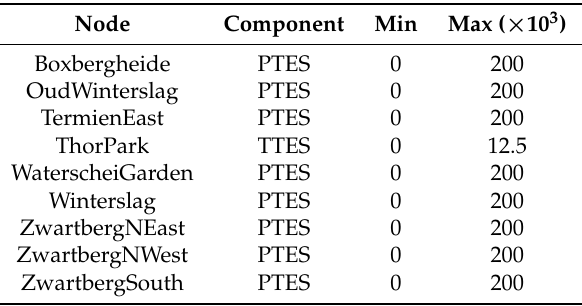
Table 1. Available design choices for TES systems at the different nodes in GenkNet. All numbers are expressed in m 3 .